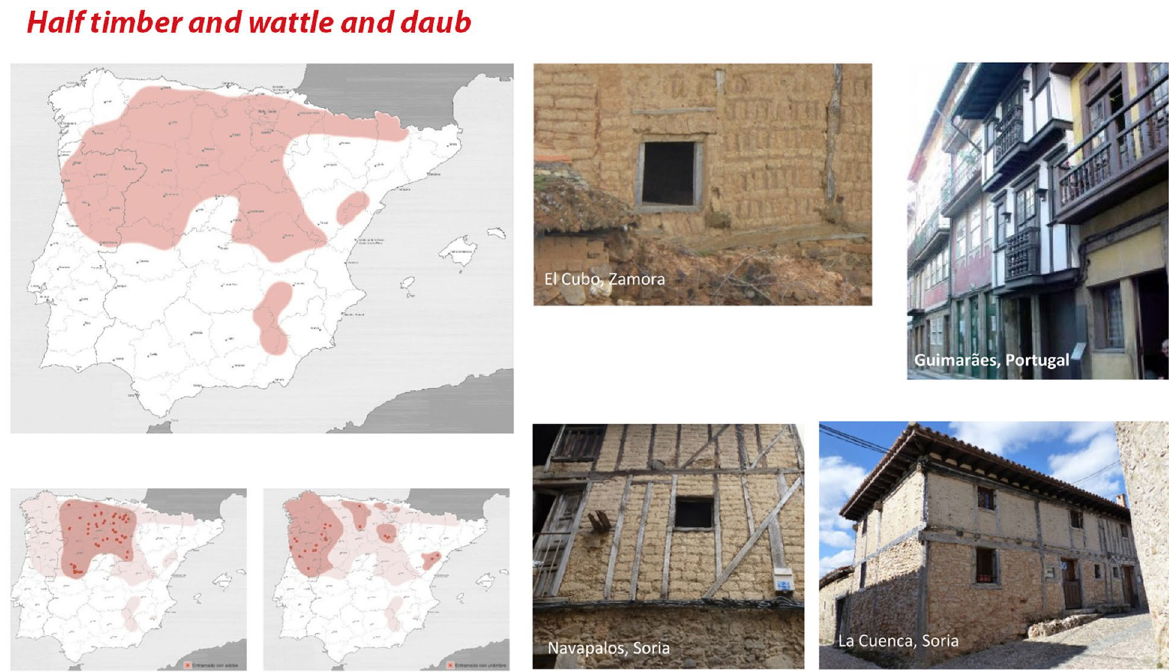
Fig. 2 Example of mapping: different timber walls techniques found in the Iberian Peninsula (Source: RES‑TAPIA & SOS‑TIERRA